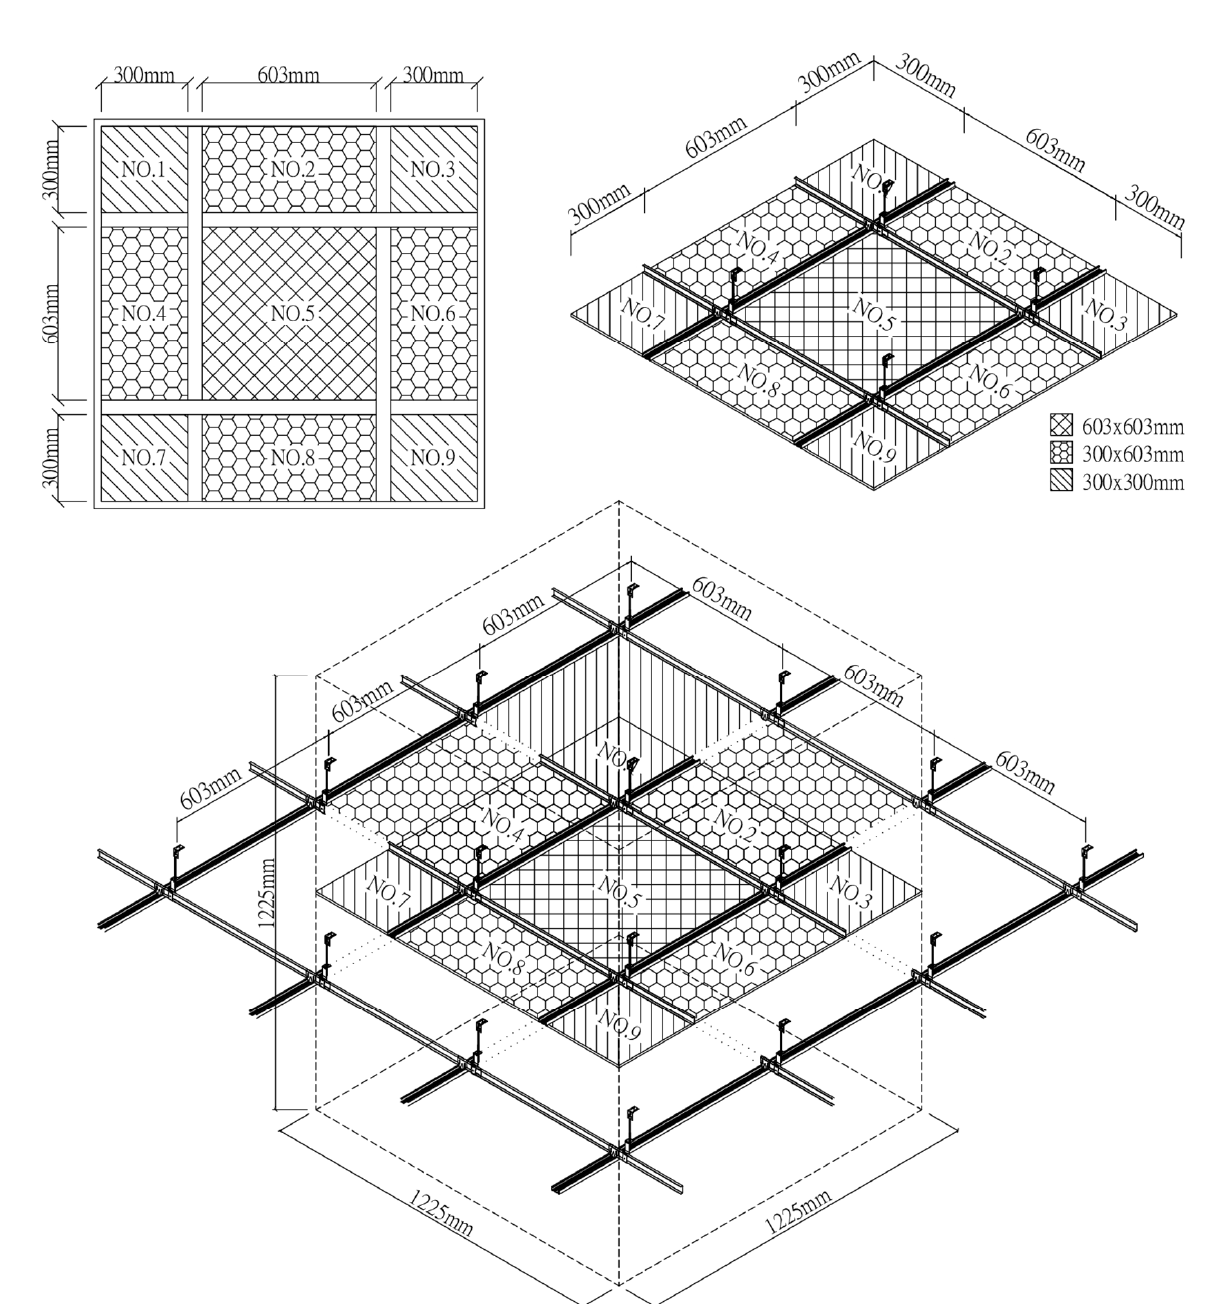
Figure 6. Suspension ceiling system.